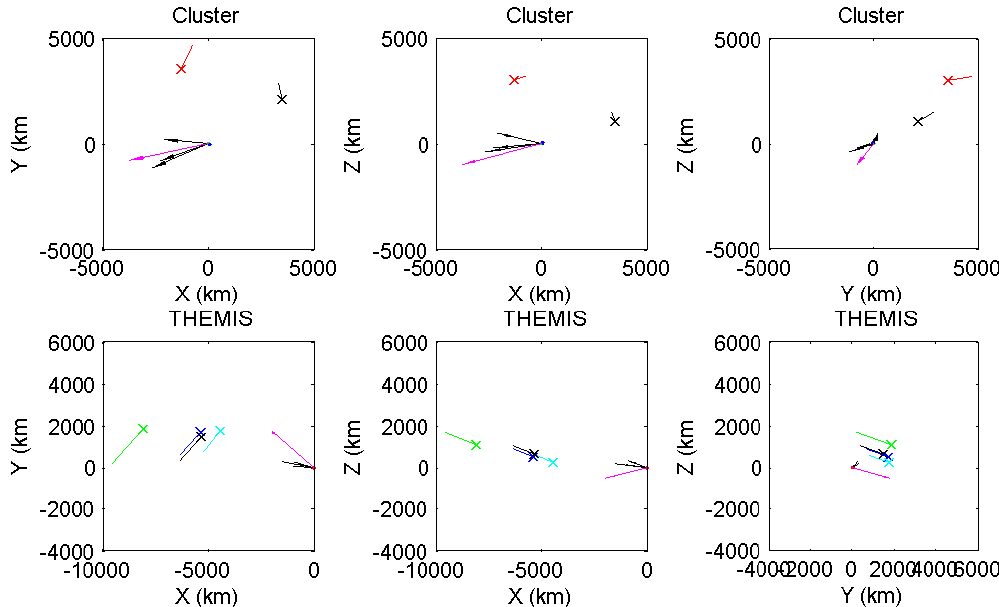
Fig. 5. The location (marked by x) and motion (marked by a line starting from the x) of the cluster (top) and THEMIS (bottom) spacecraft during the period 17:00–19:00UT. The plasma flow velocity is shown as a pink arrow from C1 and ThA. The structure velocities, determined by timing analysis, are shown as black